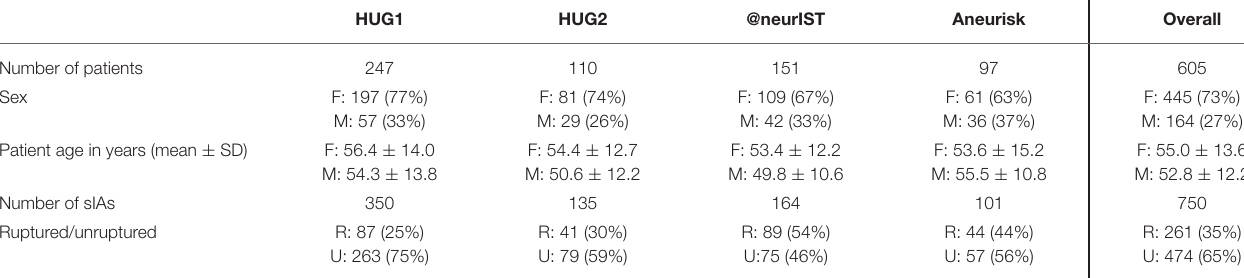
TABLE 2 | Summary of the cases included into the AneuX morphology database, stratified by data